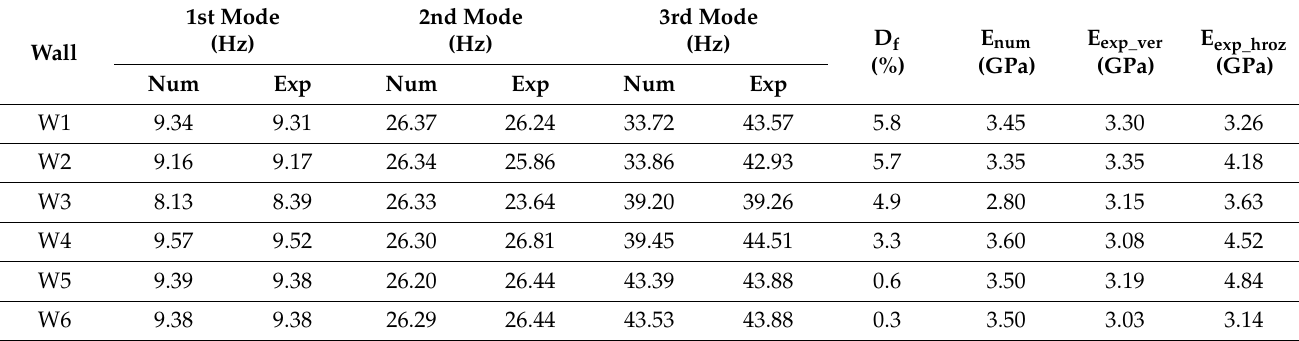
Table 4. Correlation between the measured and calculated frequencies.